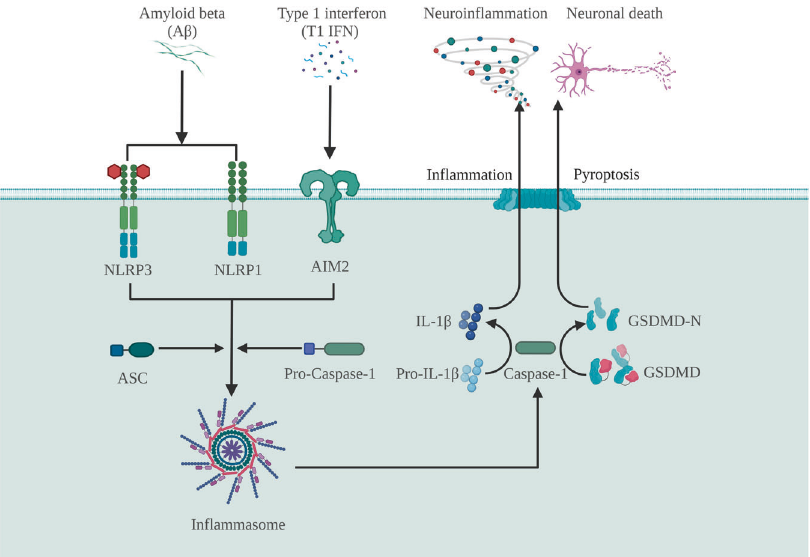
Fig. 5 Pyroptosis and AD: The classical pyroptosis pathway is involved in the pathogenesis of AD. Amyloid beta and type 1 interferon can provoke neuroin fl ammation and neuronal death through the classical pyroptotic